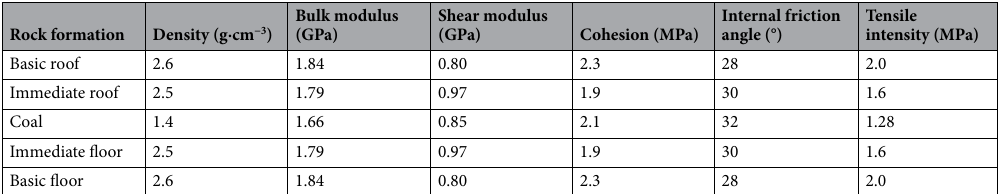
Table 1. Basic mechanical parameters.